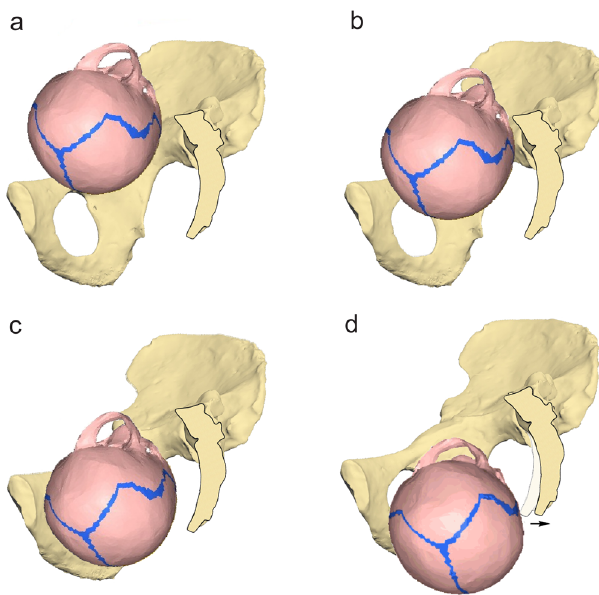
Fig. 2 Phases of bony birth simulation. A fetal head with a 145 g brain size passes through the pelvis of Sts 14 as reconstructed by Häusler and Schmid 19 , depicted in lateral view. a Position of the fetal head at the onset of the simulation in left occiput anterior position; b engagement of the head at the pelvic inlet level; c descent through the pelvic midplane after slight rotation; note that internal rotation into the expected sagittal head orientation does not occur in this model due to the absence of soft tissue. d Expulsion from the outlet with backward nutation of the sacrum by 11 mm (arrow) and further rotation (45° in total) into a transverse orientation. Only the right hemipelvis is shown for visualization